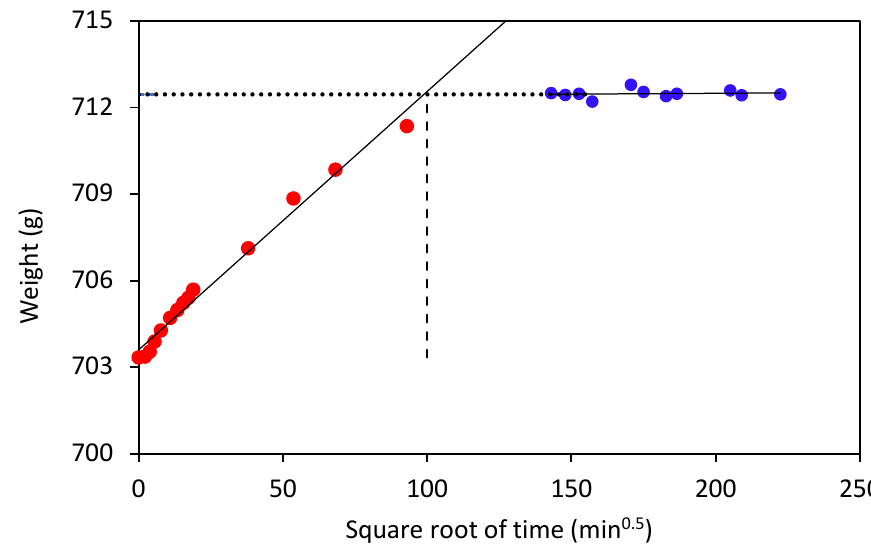
Figure 8. Water absorption curve for specimen E2-T. The percentage absorbed by the photocatalytic materials less the percentage recorded for the respective references is depicted in Figure 9. Curves lying above zero denote greater absorption by the photocatalytic material than the reference and vice-versa. The absorption parameters for all the materials are summarised in Figure 10: effective porosity, ε e , in Figure 10a and the capillary absorption coefficient, k (kg/m 2 min 0.5 ), in Figure 10b.